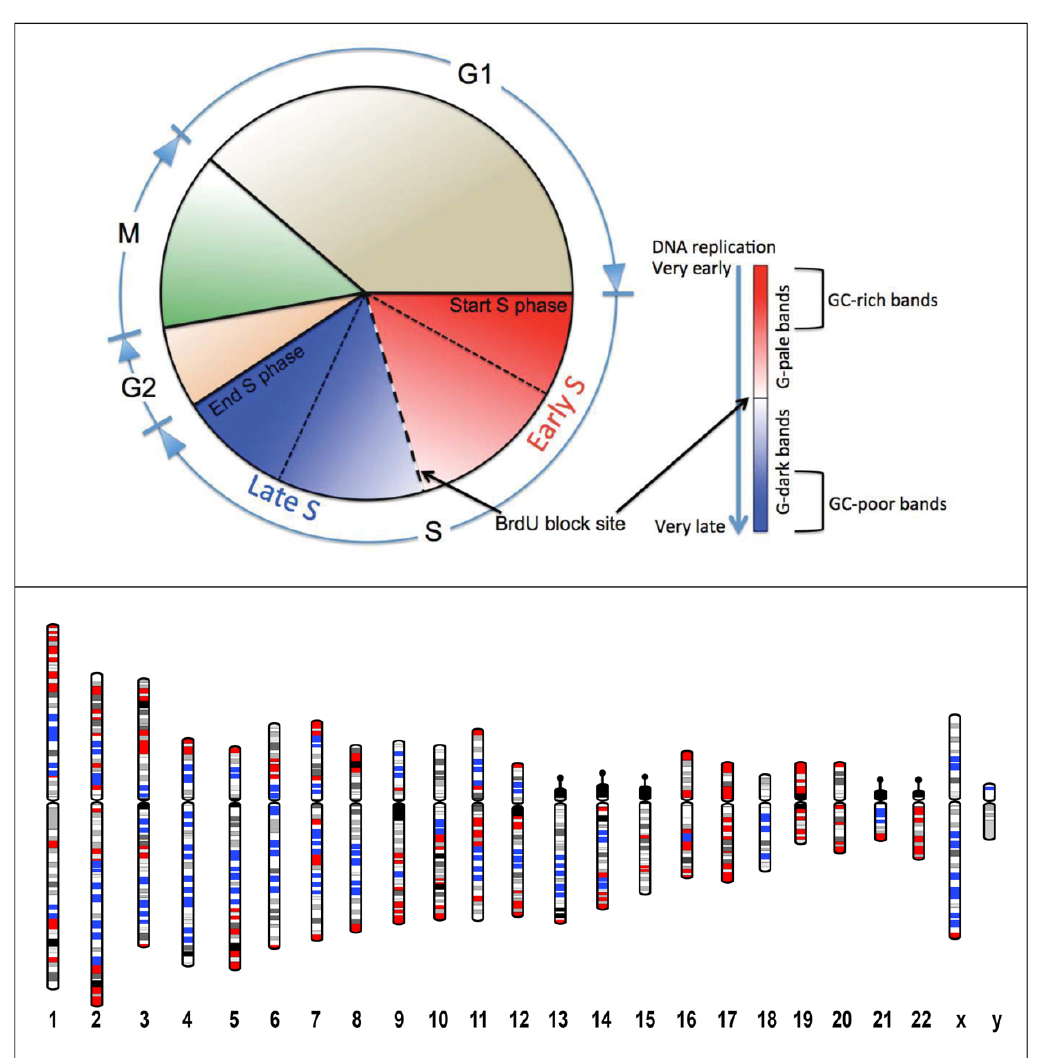
Figure 2. Replication timing of the human chromosomal bands. Upper panel. Scheme of the cell cycle with the S phase and its different temporal sections highlighted. S phase is the period when the DNA is replicated and could be divided into two parts taking into consideration the block of the cell cycle that happens when the cells grow in a medium with a high concentration of bromodeoxyuridine (BrdU). In this way, the early S phase corresponds to the period in which DNA from the GC-rich pale G-bands is replicated, and the late S-phase is the period in which the GC-poor DNA from the dark G-bands is replicated. Moreover, the gene-richest bands are replicated at the beginning of the S phase (very early replicated DNA), and the gene-poorest bands at the end (very late replicated DNA). The remaining bands, endowed with an intermediate gene density, are replicated in the middle part of the S phase, first the G-pale bands and then the G-dark bands. Bottom panel. Human chromosome ideograms with G-bands showing the GC-richest and the GC-poorest bands [35,36] highlighted by red and blue colors, respectively. Note that the GC-richest bands (red colored) and the GC-poorest bands (blue colored), namely the two band sub-sets replicated in two very different subperiod of the S phase, are generally not adjacent. The other bands, with intermediate compositional properties, are replicated in the central part of the S phase.